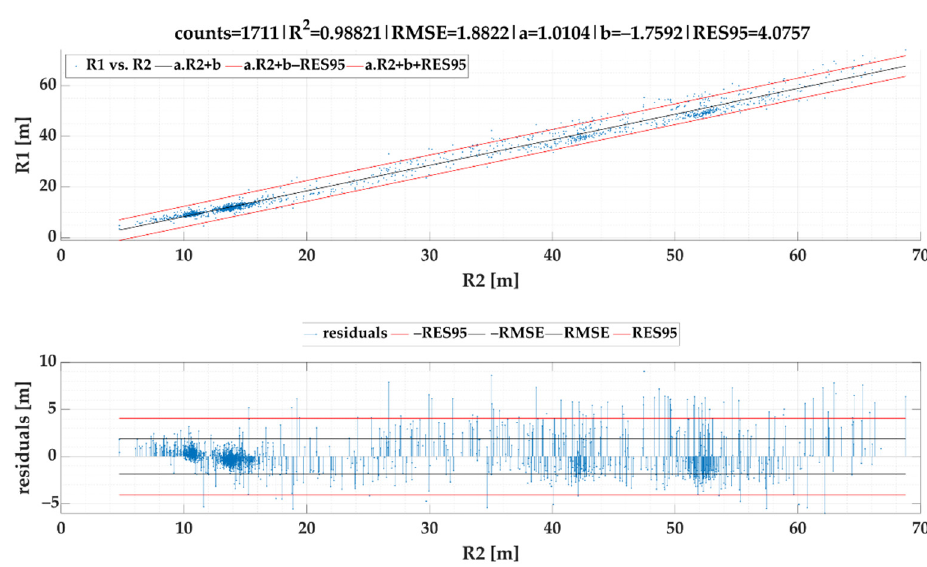
Figure 9. Turning radius R 1 vs. R 2 of events for SEL 1.